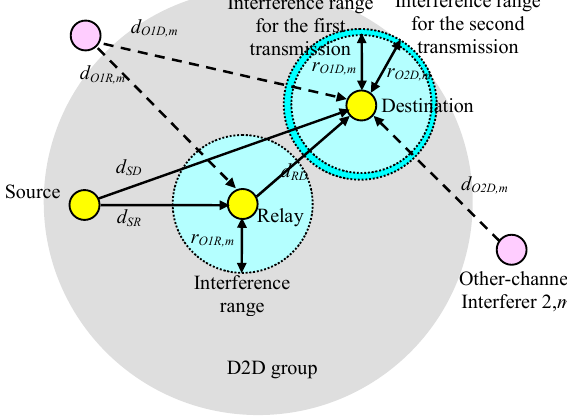
Figure 7. Interference from other sub-channels.